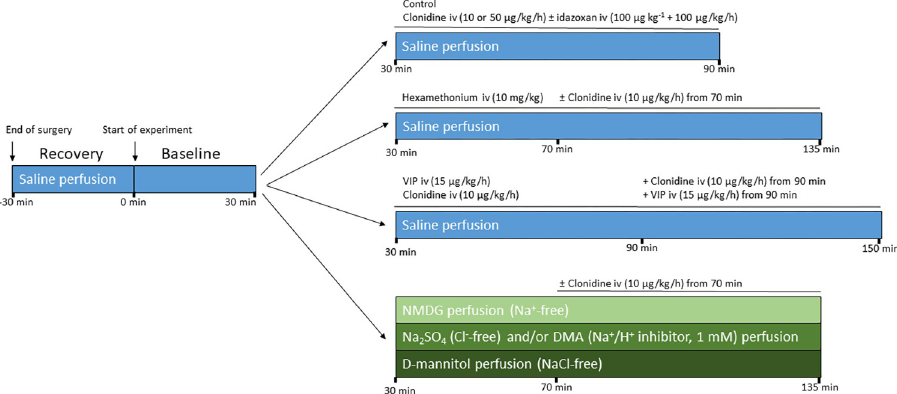
Fig 1. Experimental setups of the intestinal perfusion. In all rat groups, the duodenum was initially perfused (0.4 mL/min) with isotonic saline (blue) for 30 min (stabilization period) followed by a 30 min period to assess basal values of luminal alkalinisation and net fluid flux. Each group was thereafter perfused with isotonic saline for 60, 105 or 120 min, or with a solution free from Na + (light green), Cl - (green), or NaCl (dark green). Each of these groups were tested alone, and after intravenous clonidine treatment. In one set of experiments, clonidine was also tested with or without intravenous VIP, and in another with or without luminal DMA, a Na + /H + exchange